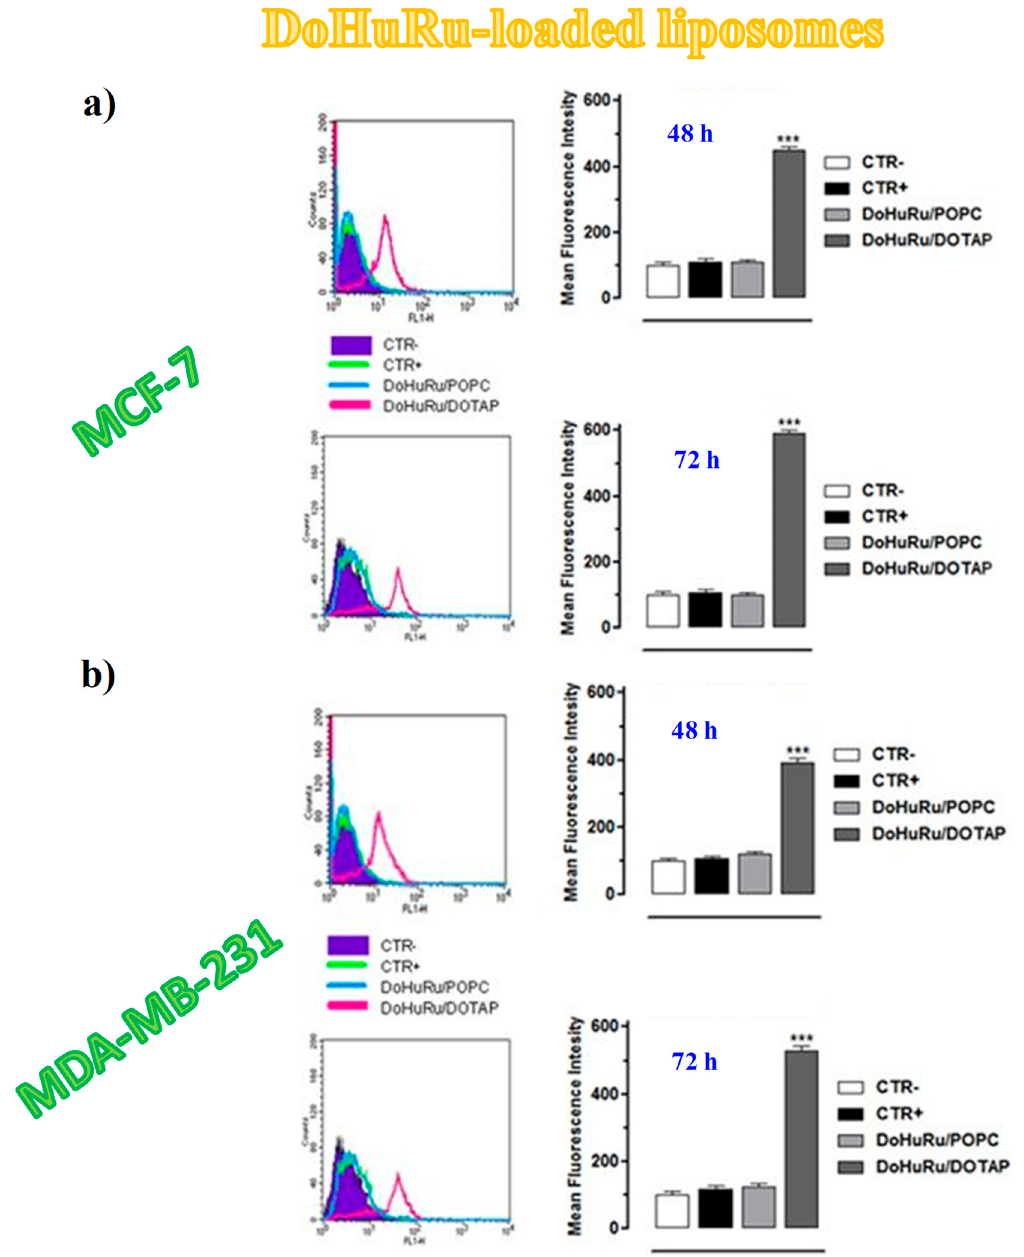
Figure 14. Quantitative flow cytometric analysis of autophagosomes formation (MDC incorporation) in MCF-7 ( a ) and MDA-MD-231( b ) breast cancer cells for the autophagy activation evaluation: unlabelled and untreated (CTR − ), labelled and untreated (CTR +), treated with IC 50 concentrations of DoHuRu/POPC or with DoHuRu/DOTAP formulations for 48 and 72 h, as indicated. In the bar graphs, calculated main fluorescence intensities (MFIs) values are expressed as percentage of control cells. Figures are adapted from [134].